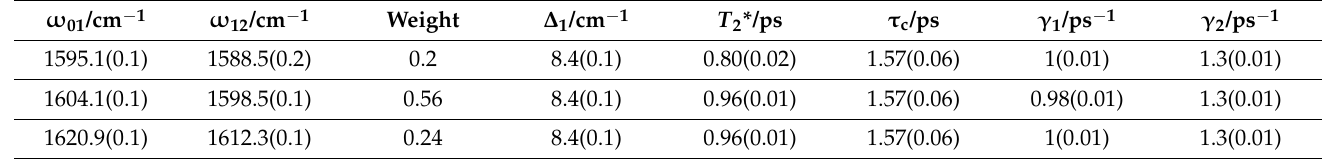
Table 2. Results of the fit of linear IR and 2DIR experimental spectra using phenomenological